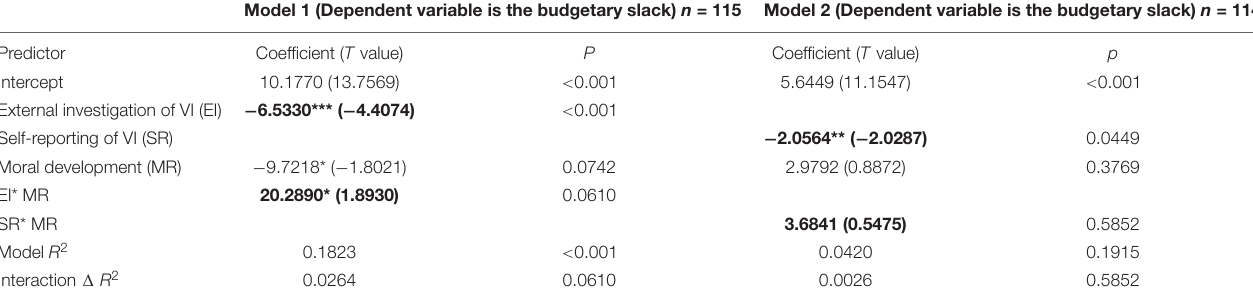
TABLE 3 | Ordinary least squares regression to test the moderating effect of moral development on the relationship between accountability-oriented control characteristics of VI and budgetary slack. Model 1 (Dependent variable is the budgetary slack) n = 115 Model 2 (Dependent variable is the budgetary slack) n =